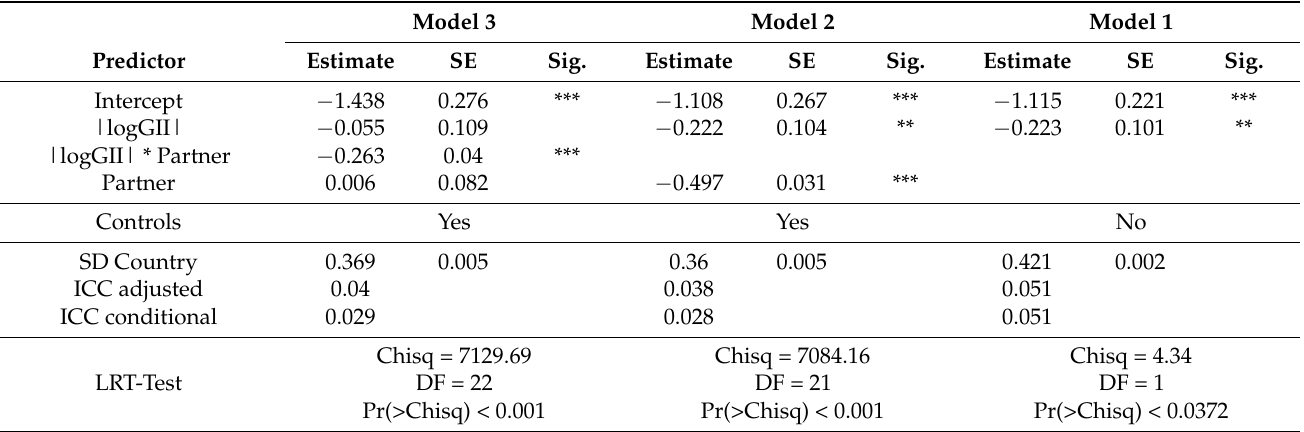
Table 2. Multilevel logistic regressions of the effect of GII on